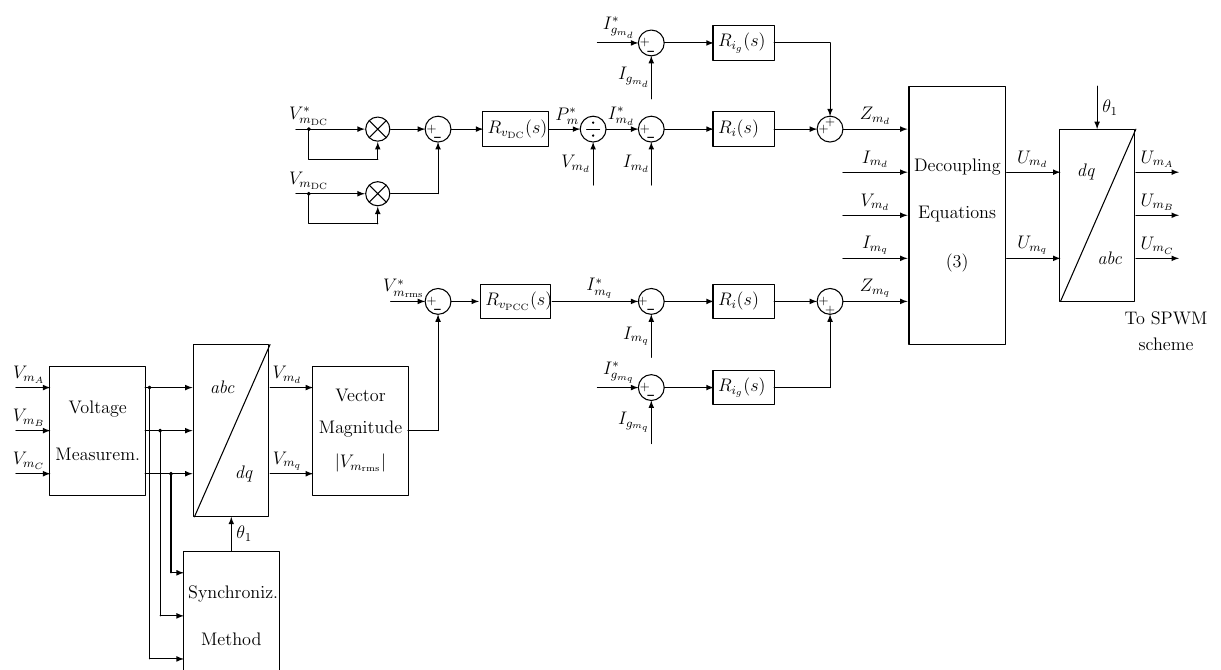
Figure 4. Proposed control scheme of the VSC that regulates the DC voltage across the DC bus. SPWM—sinusoidal pulse-width